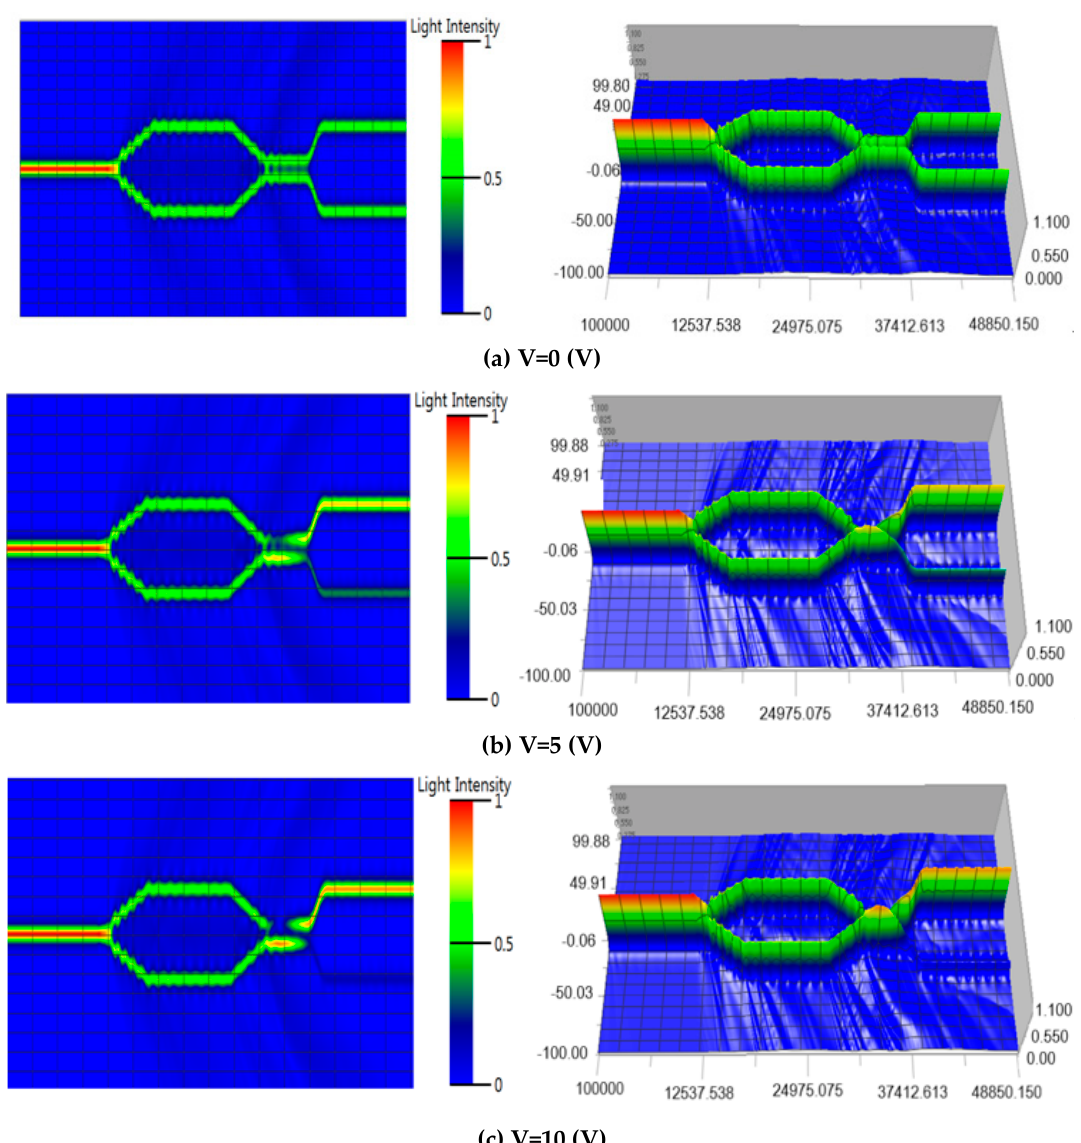
Figure 3. Three-dimensional BPM-CAD simulation results with the following applied voltages: ( a ) 0 V, ( b ) 5 V, and ( c ) 10 V.